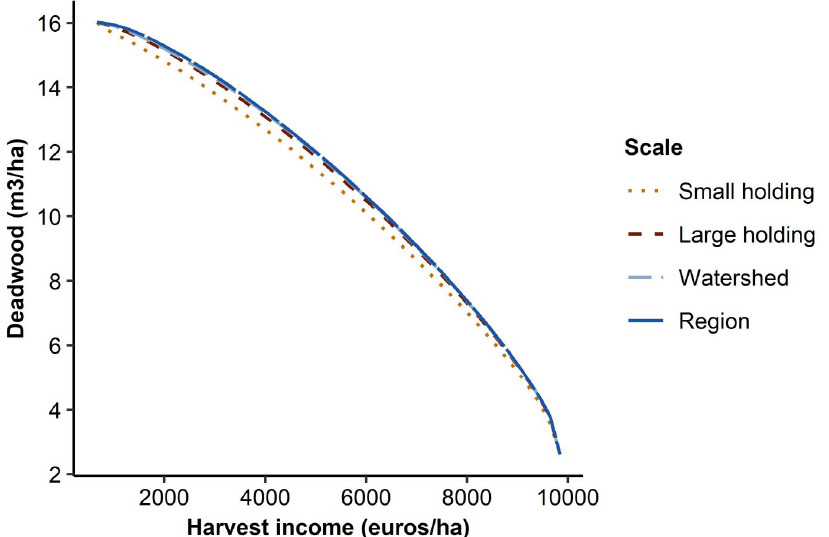
Fig 3. Trade-off between harvest income and deadwood availability. Production possibility frontiers illustrating the trade-off between harvest income and deadwood availability when forest management was optimized at different spatial scales.